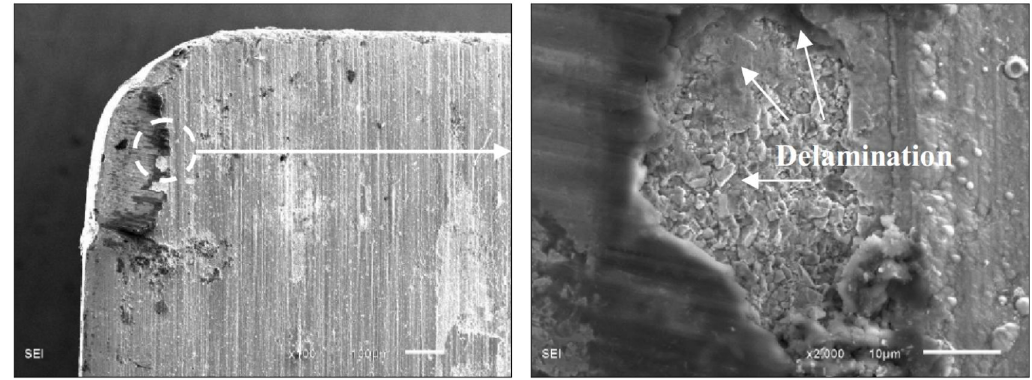
Figure 15. Delamination micrograph of ZGC coating on the rake face.